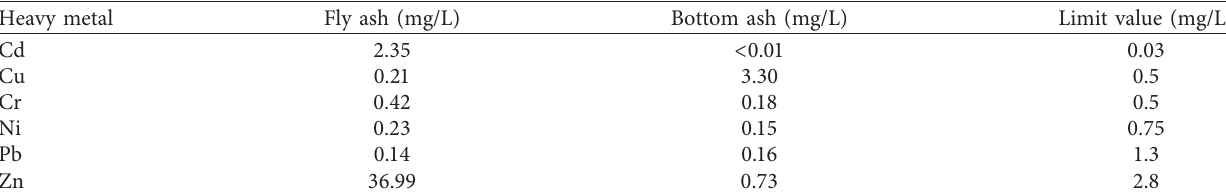
Table 3: Leaching concentration of MSWI fly ash and bottom